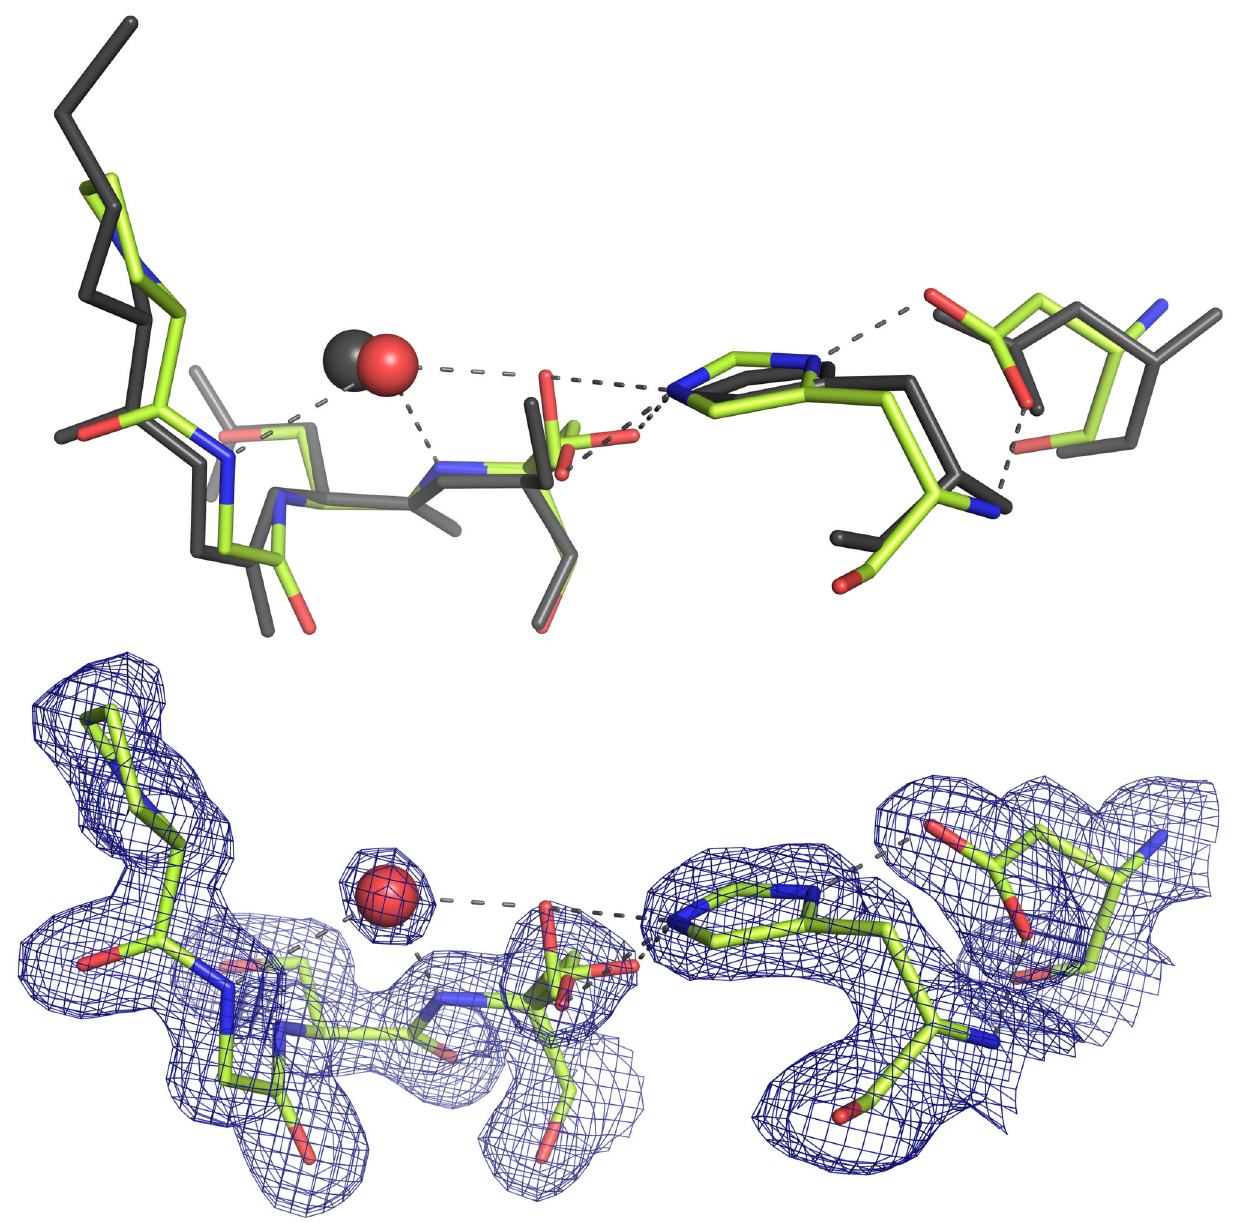
Figure 4. The crystal structure of SplD demonstrates canonical conformation of the catalytic triad and the oxyanion hole. (Upper panel) Catalytic triad residues and the main chain fragment constituting the oxyanion hole of SplD (limon) superposed with corresponding residues of chymotrypsin (black). (Lower panel) Electron density (contoured at 1.1σ) around SplD fragment depicted in the upper panel. Red sphere represents a water molecule. Dashed lines represent hydrogen bonds.